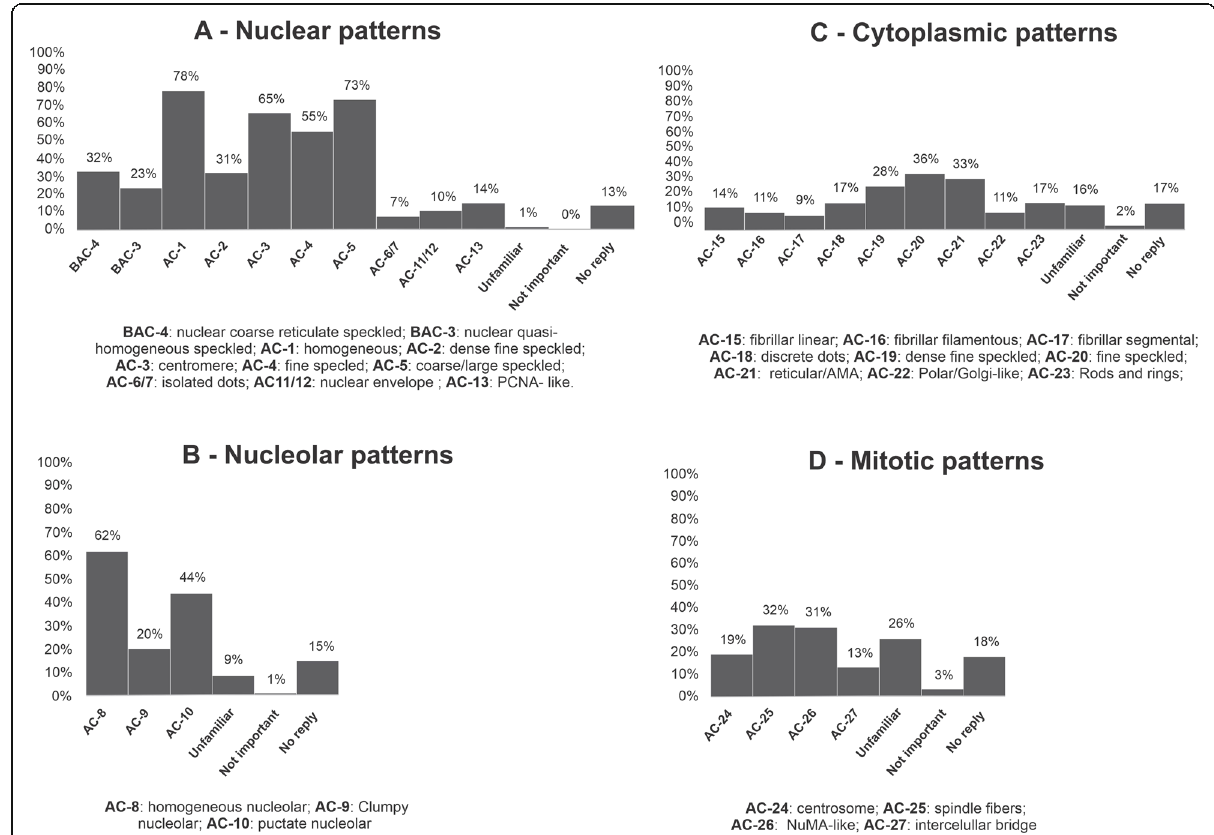
Fig. 1 Relevance attribute by rheumatologist to the four groups of autoantibody patterns in HEp-2 cells: nuclear, nucleolar, cytoplasmic and mitotic. Histograms depict the frequency of participants that classify the patterns as relevant. Unfamiliar and Not important refer to the group of patterns in each cell